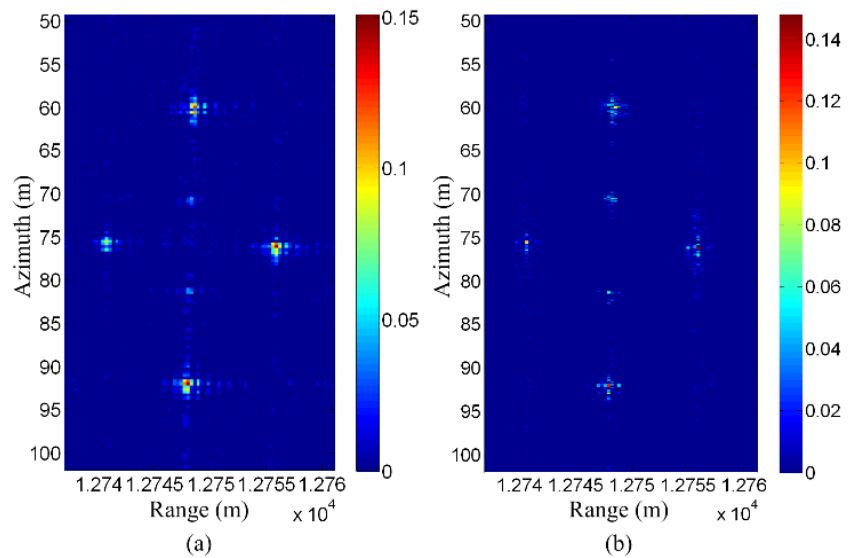
Figure 9. ( a ) Conventional CS reconstruction result (reconstruction time = 44,032 s). ( b ) Segmented reconstruction result (reconstruction time = 1498 s) (taken from [71]).